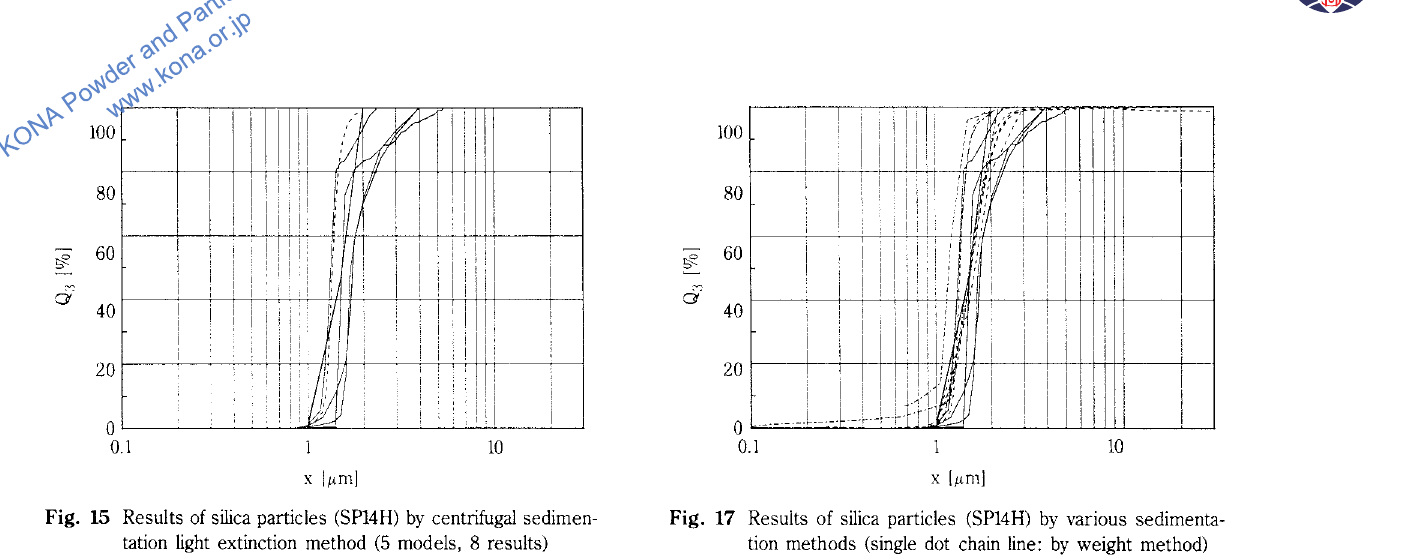
Fig. 17 Results of silica particles (SP14H) by various sedimenta tion methods (single dot chain line: by weight method)